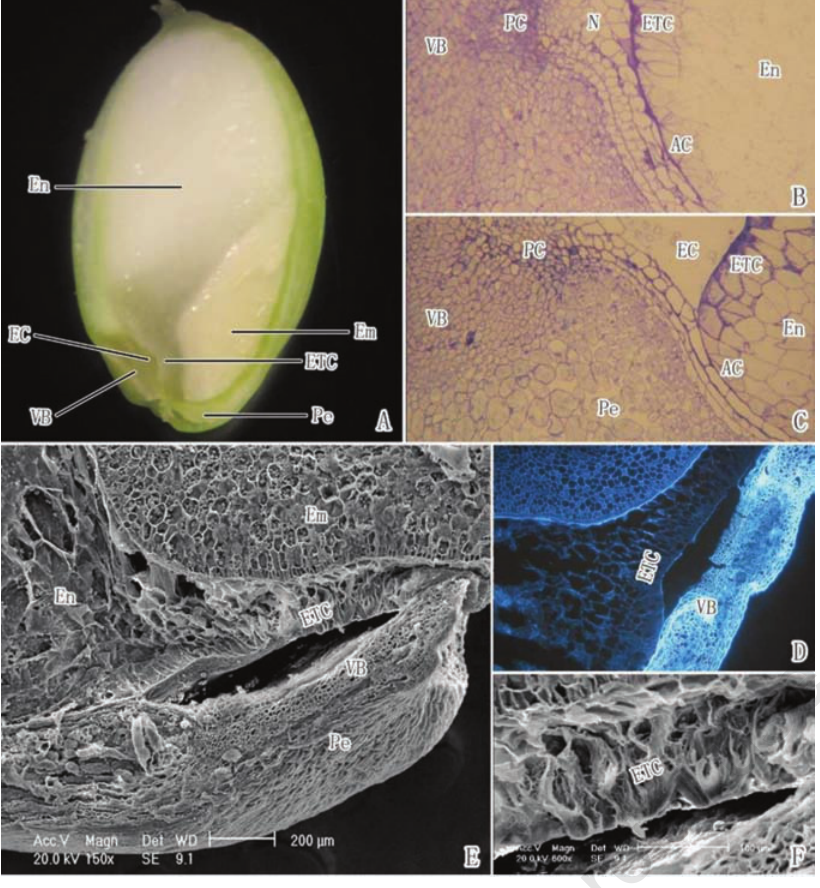
Figure 1. The distribution and configuration of sorghum endosperm transfer cells. (A) longitudinal section of the sorghum caryopsis under the stereomicroscope (magnifica- tion: 15X); (B,C) region between the filial and maternal tissues under the light micro- scope (200X); (D) sorghum endosperm transfer cells under the fluorescence microscope (100X); (E,F) sorghum endosperm transfer cells under the scanning electron microscope (E: 150X, F: 600X). A, 15 DAP; B, 6 DAP; C, 9 DAP; D,E,F, 20 DAP; En, endosperm; Em, embyo; ETC, endosperm transfer cells; EC, endosperm cavity; VB, vascular bundles; Pe, pericarp; PC, placentochalazal cells; AC, aleurone cells; N, nucellar cells.